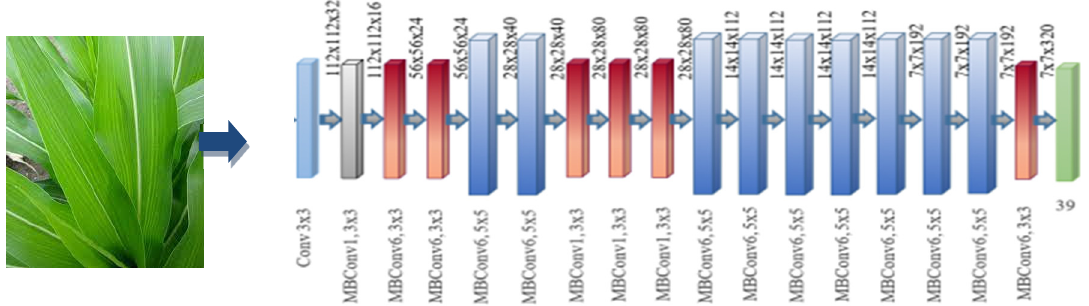
Figure 4. Schematic representation of E ffi cientNet.